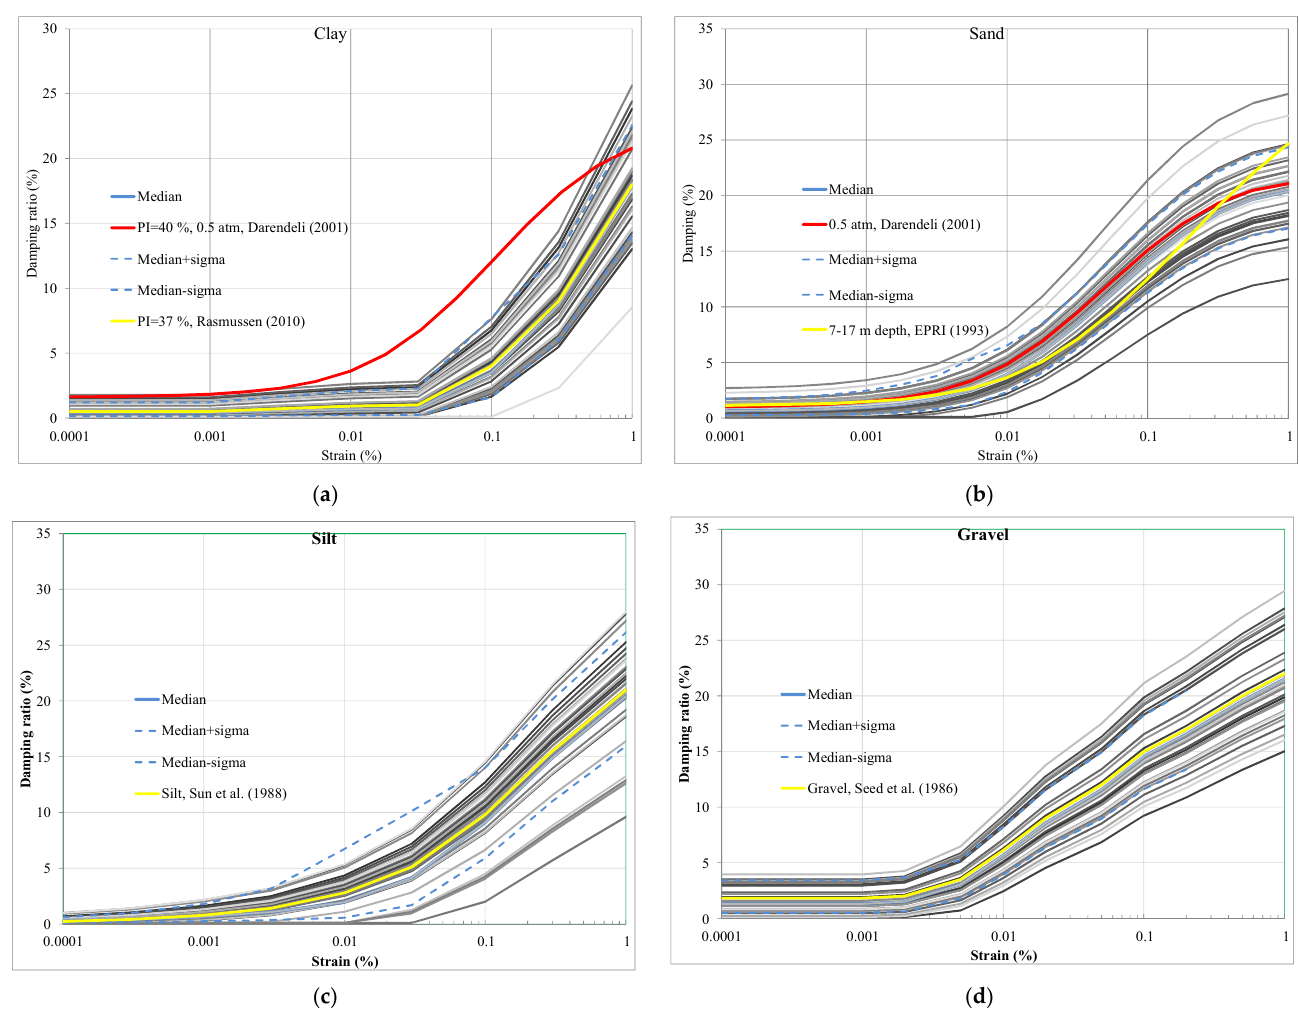
Figure 8. Thirty random damping ratio versus strain (%) curves for ( a ) clay, ( b ) sand, ( c ) silt, and ( d ) gravel. The curves in gray in the above figures are generated from the randomization.